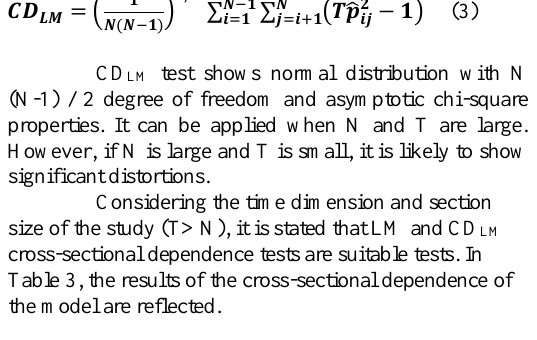
Table 3: Cross-Sectional Dependence